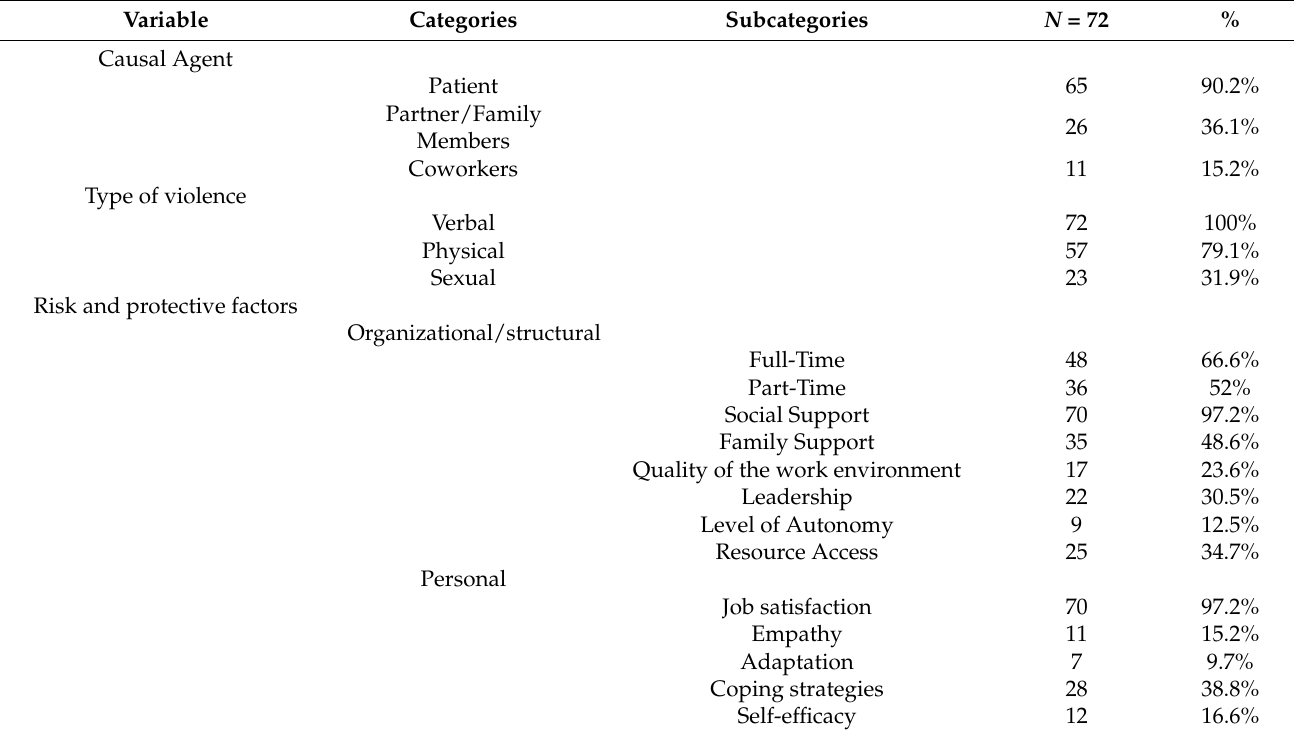
Table 4. Main characteristics of the violence suffered at workplace and the protective and risk factors. Variable